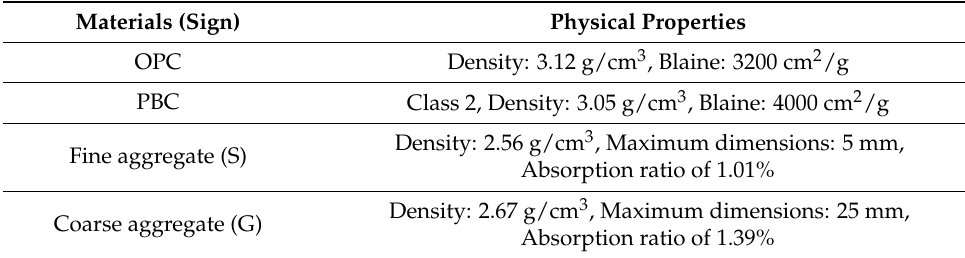
Table 4. Physical properties of used materials.